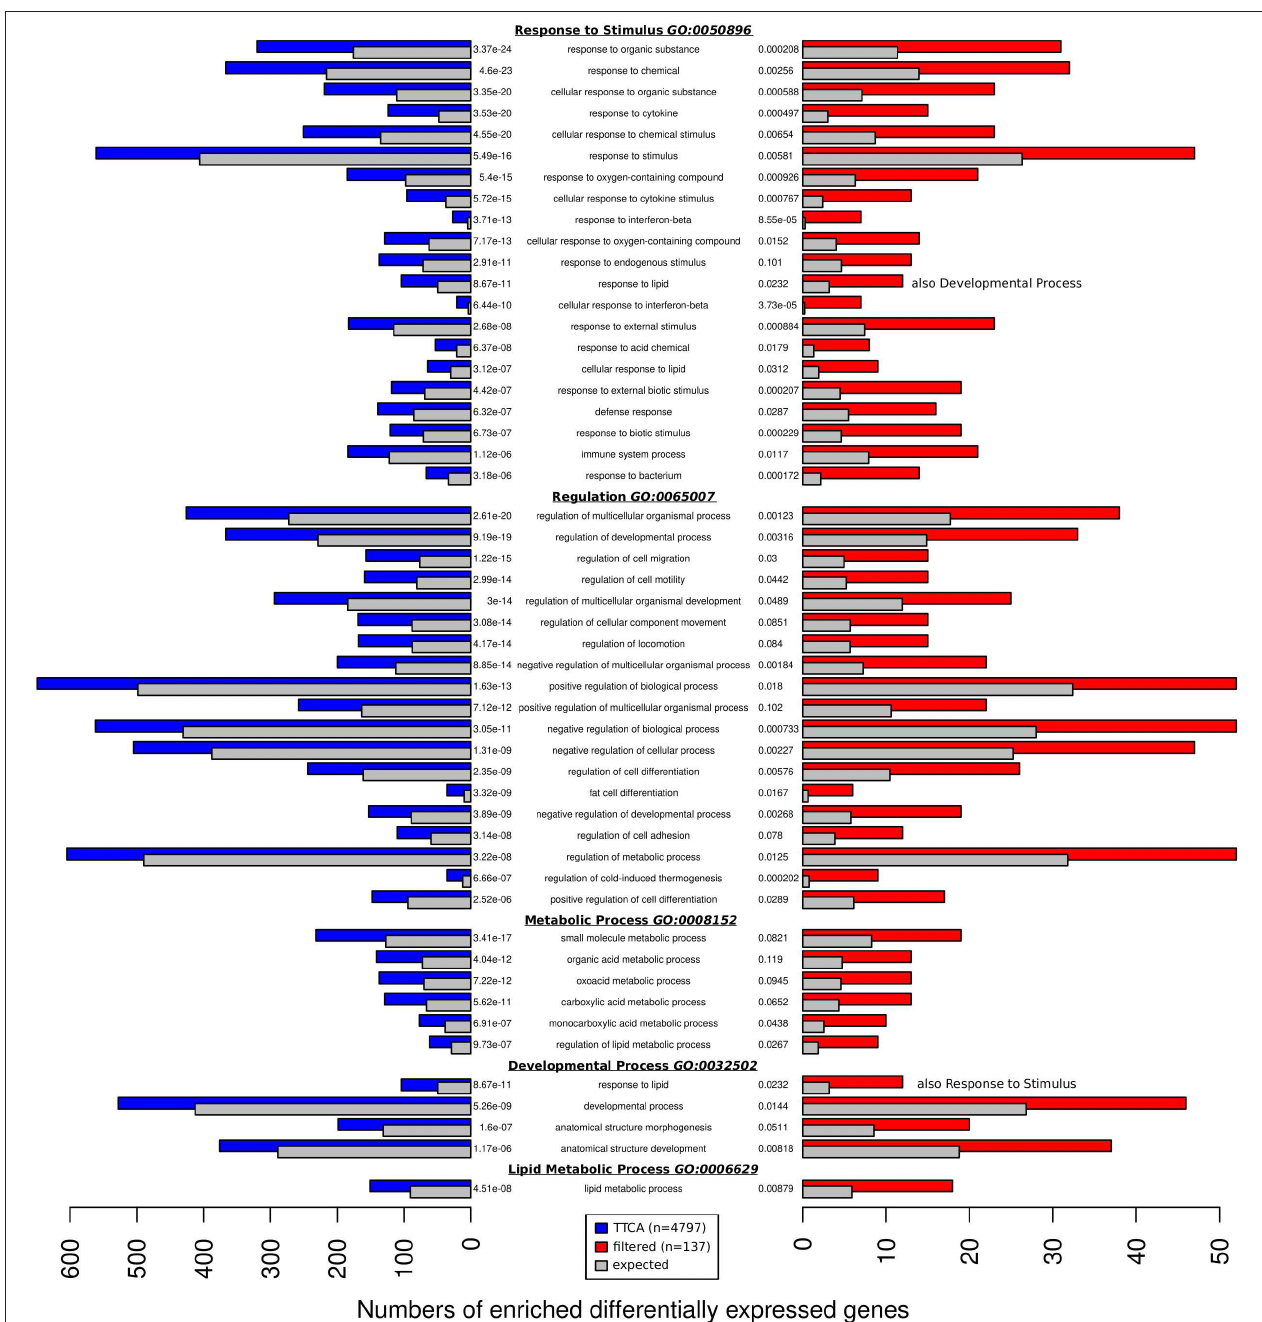
FIGURE 3 | The overlap of the 50 most enriched GO terms found with genes reported by TTCA (4,797 blue) 137 filtered genes (red). The colored bars represent the number of genes assigned to the GO-term and compares it to the number of genes expected to be assigned to the term by chance (gray). The GO-terms can be categorized to five general biological processes: Response to Stimulus, Regulation, Metabolic Process, Developmental Process, and Lipid Metabolic Process. Each block is ordered by false discovery rate (FDR).